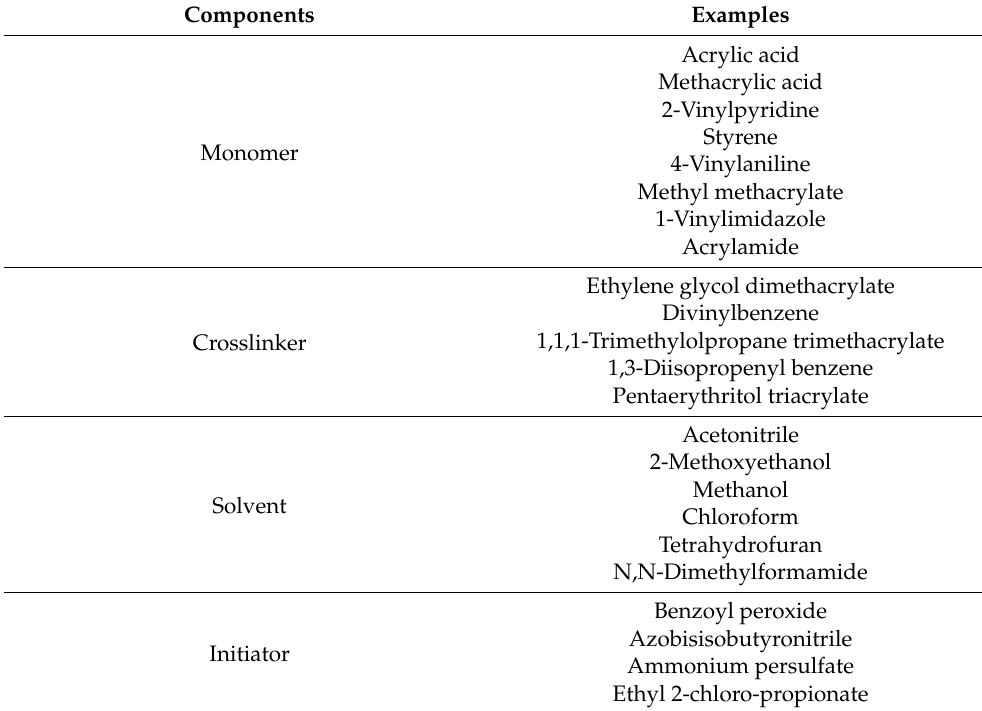
Table 1. Commonly used reagents in the preparation of MIPs.